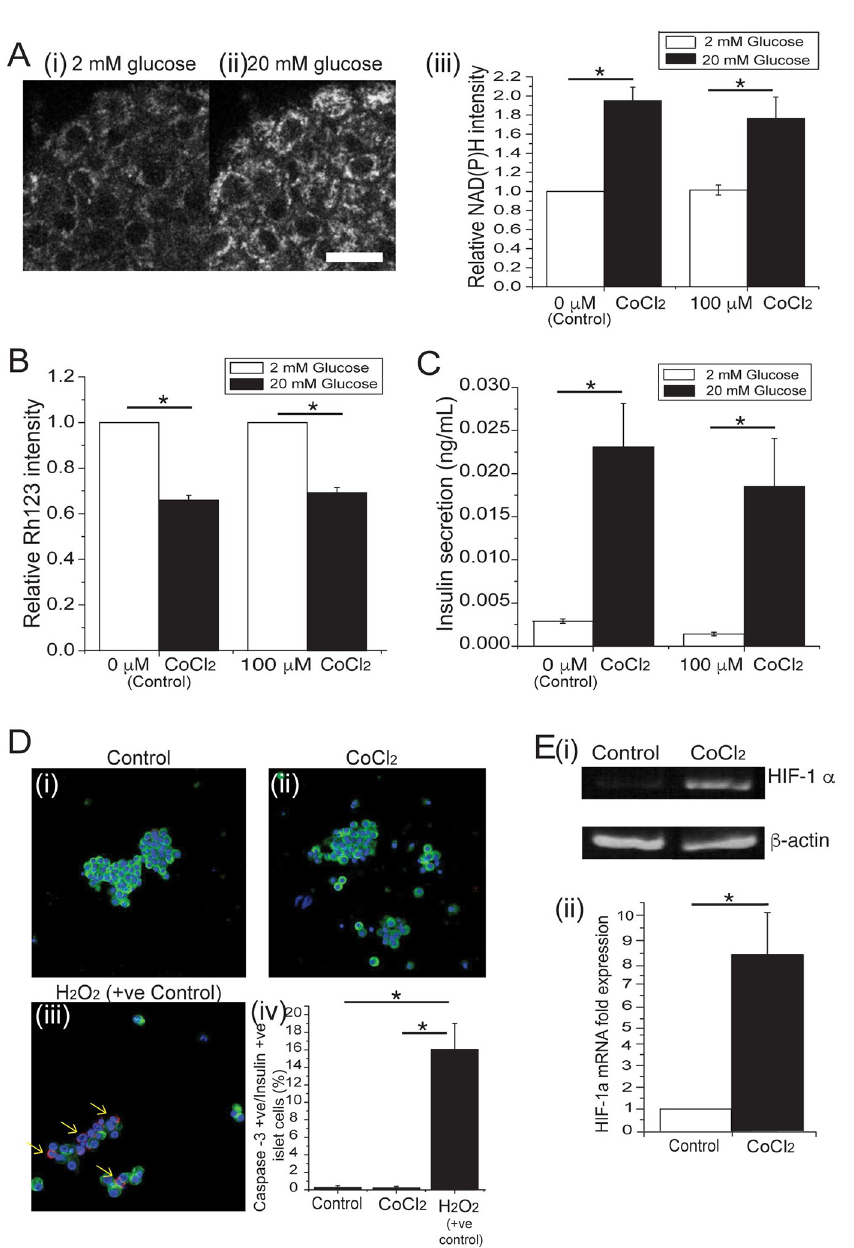
Fig 1. Induction of moderate hypoxia in isolated islets with CoCl 2 . (A) A representative two-photon NAD(P)H image of an isolated pancreatic islet in (i) 2mM and (ii) 20 mM glucose (Scale bar = 40 μ m). (A)(iii) Relative NAD(P)H intensities of islets cultured in the absence (0 μ M) and presence (100 μ M) of CoCl 2 (n = 3 mice on separate days). (B) Relative Rh123 intensity of islets in response to 2mM (white bars) and 20mM (black bars) glucose (n = 5 mice on separate days). (C) Insulin secretion (ng/mL) from islets in response to 2 mM (white bars) and 20 mM (black bars) glucose (n = 4 mice on separate days). (D)(i-iii) Representative images of islets dispersed to single cells after being cultured in the absence (0 μ M) and presence (100 μ M) CoCl 2 . Islets dispersed into single cells were stained for insulin (green), caspase-3 (red) and DAPI (blue). Arrows show caspase-3 positive cells in H 2 O 2 -treated cells (H 2 0 2 : +ve control). D(iv) Images were subsequently quantified to determine the percent of Caspase-3 +ve / insulin +ve cells (n = 3 mice on separate days). (E)(i) Image of RT-PCR and (ii) qPCR of HIF-1 α transcript expression of islets (n = 5 mice on separate days). Error bars are ± SEM. � p < 0.05. All images were identically Gaussian filtered and stretched for visualization.